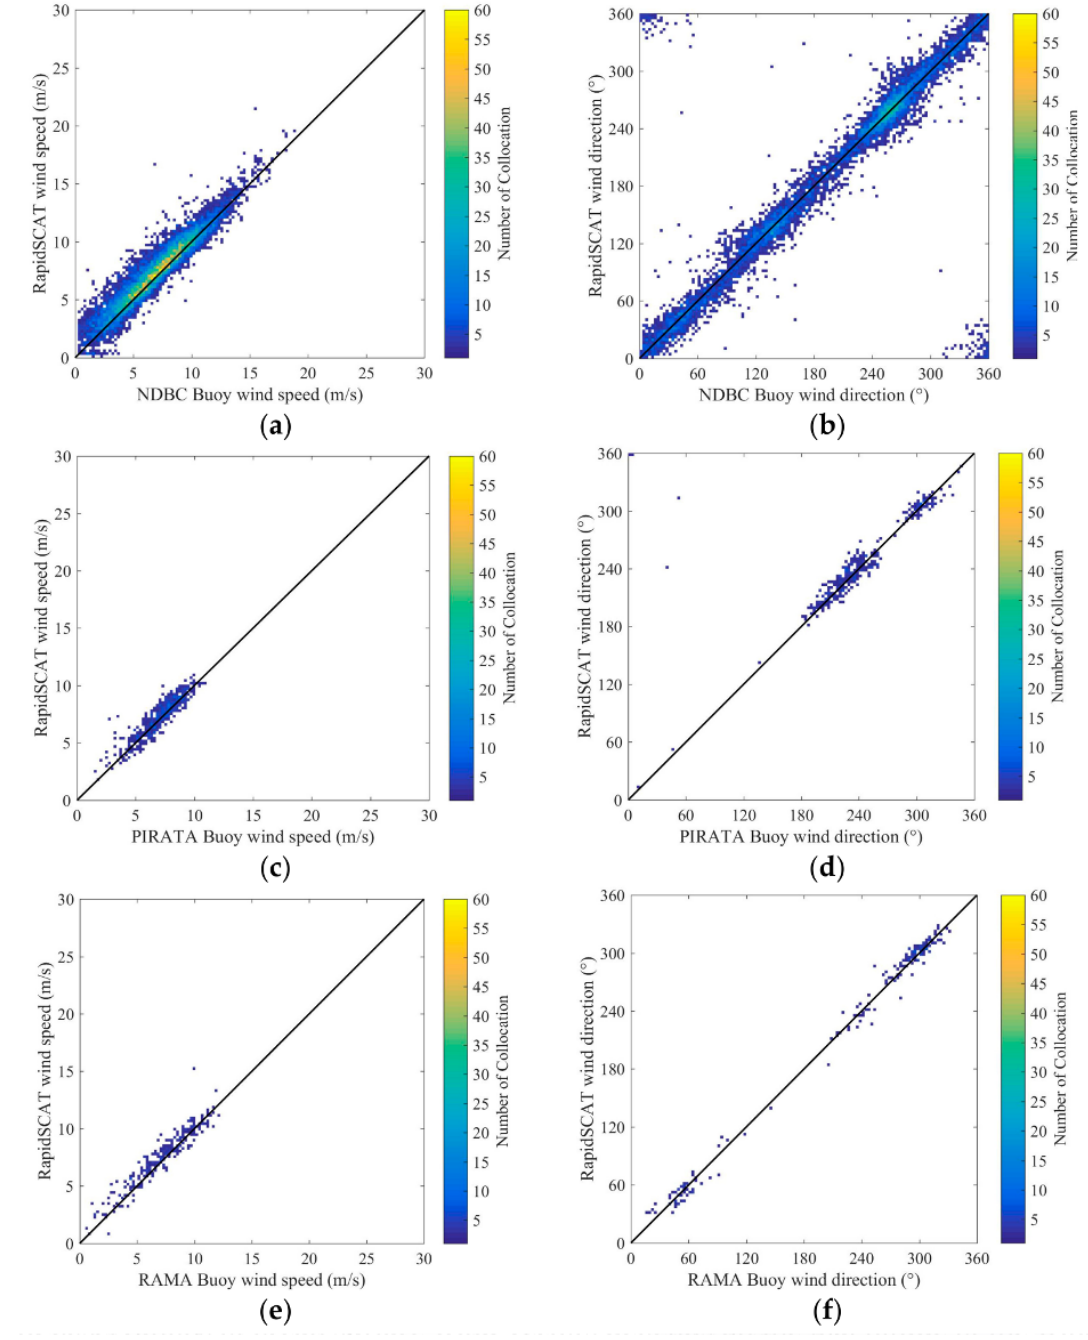
The statistical parameters of errors between RapidScat and buoys are given in Table 2. The biases and RMSEs of RapidScat wind speeds compared with different buoys are between 0.38 and 0.68 m/s and 1.35 and 1.76 m/s, and the biases and RMSEs of RapidScat wind directions compared with different buoys are 0.31 ◦ –1.41 ◦ and 17.4 ◦ –19.8 ◦ . The overall average biases and RMSEs are 0.59 m/s and 1.42 m/s for wind speed, and 0.72 ◦ and 19.5 ◦ for wind direction, respectively. The correlation coefficients are also shown to be consistent between RapidScat wind vectors and buoy wind